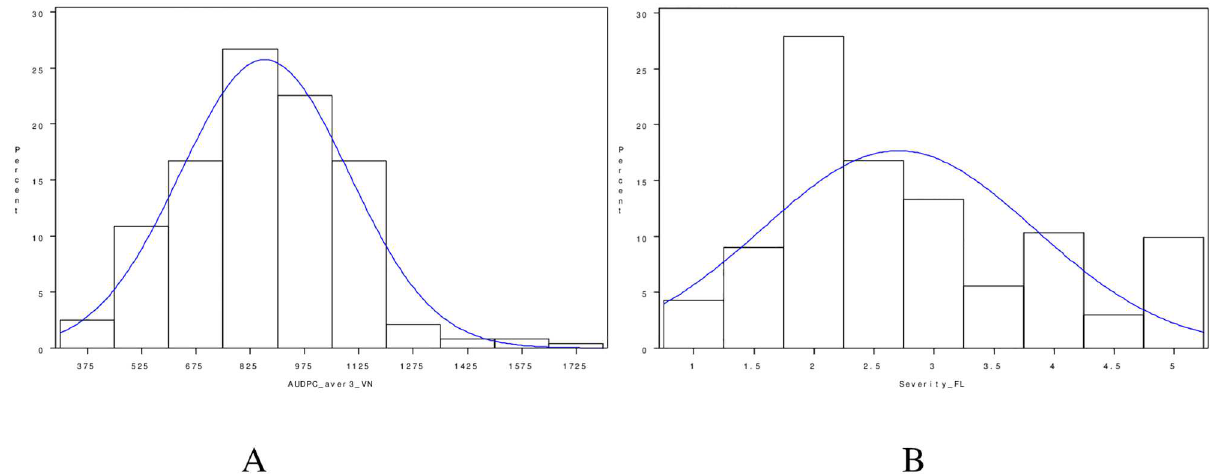
Fig 1. Distribution of disease resistance assessments of the mapping population evaluated at two field locations. (A) Area under disease progress curve (AUDPC) calculatedfor the evaluation at the PPRI, Ha Noi, Vietnam. (B) Diseaseseverity calculatedfor the evaluationat the North Florida Research and EducationCenter (NFREC), Quincy, Florida,